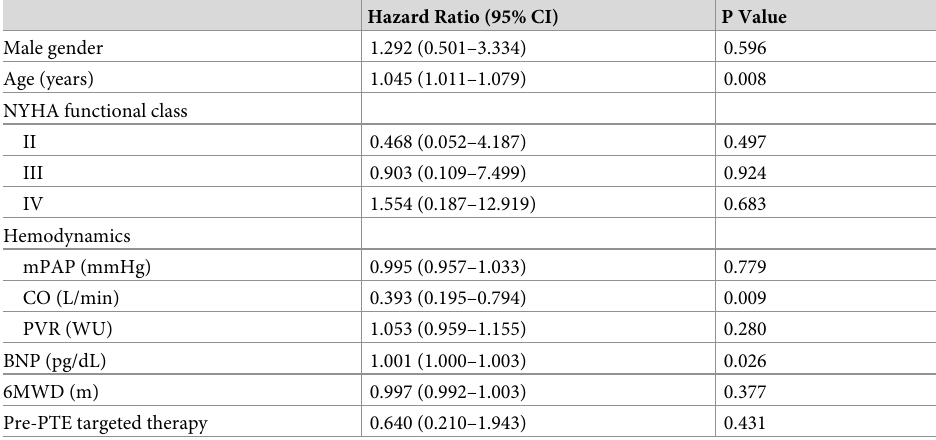
Table 2. Univariate analysis of selected baseline variables.